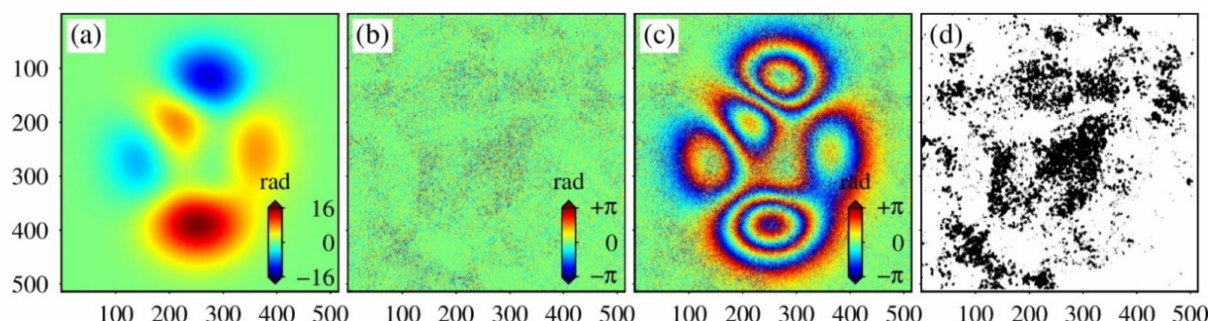
Figure 4. ( a ) Unwrapping phase simulated by Peaks function; ( b ) phase noise simulated according to coherence; ( c ) phase obtained by rewrapping after adding ( a , b ); ( d ) phase hierarchical results where white represents high-quality first-level phase points, and black represents low-quality second-level phase